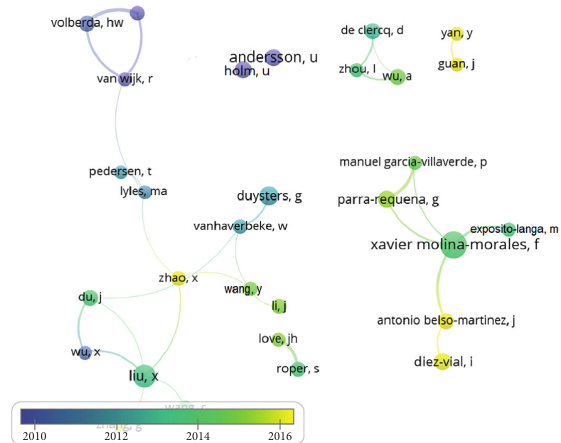
Figure 5: Temporal evolution of scientific production in each author networks. Source: own elaboration with Web of Science and Scopus data (2018) processed with VOSviewer